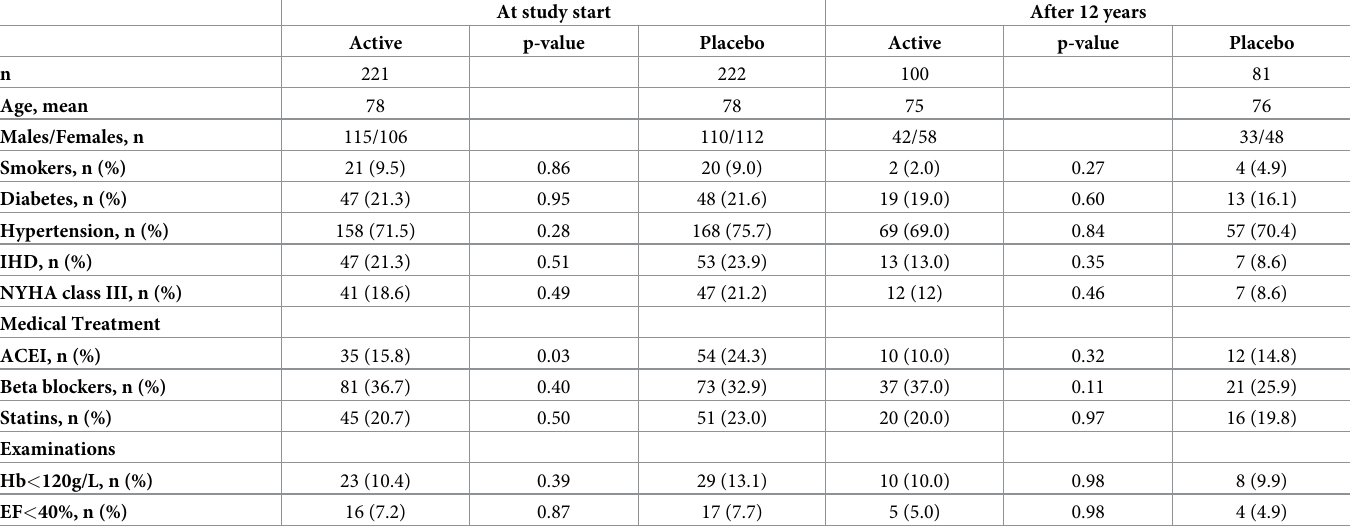
Table 1. Population characteristics at inclusion, and after 12 years.